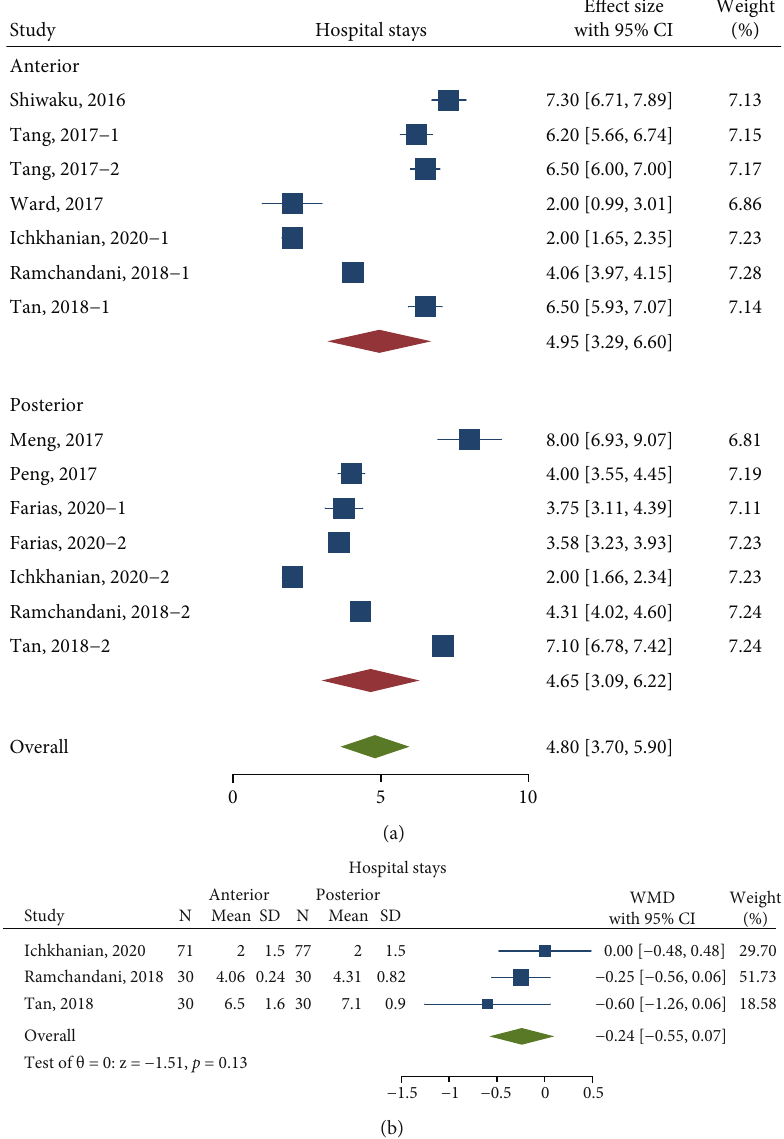
Figure 5: (a) Forest plot, Comparison of hospital stays before balancing baseline; (b) Forest plot, hospital stays di ff erence between anterior and posterior approaches after balancing baseline Labels 1 and 2 were sectionalizations inside the study. They grouped these factors as follows: preoperative intervention/non-preoperative intervention (Tang, 2017), FTM/CM (Duan, 2017), Chagas/idiopathic (Farias, 2020), and anterior/posterior (Ramchandani, 2018; Tan,